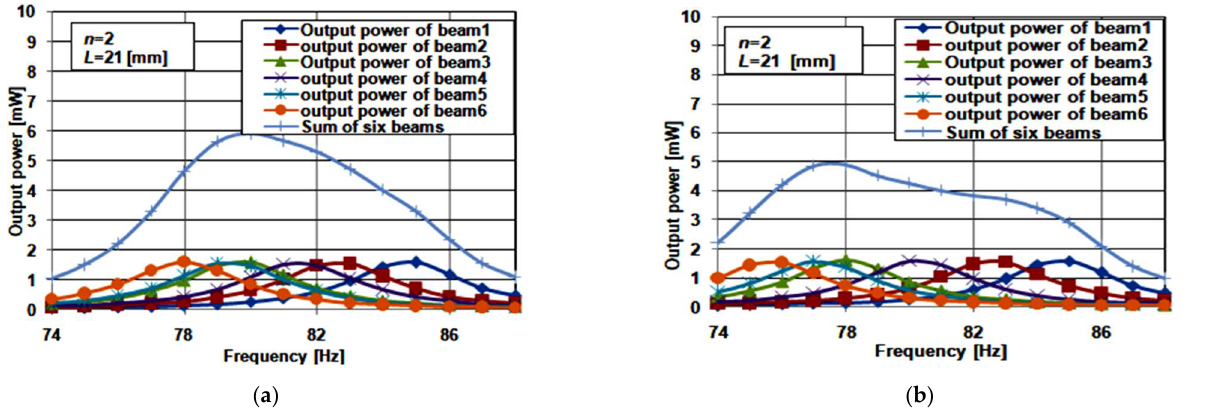
Figure 9. Frequency response six beam array: ( a ) case 1; and ( b ) case 2.